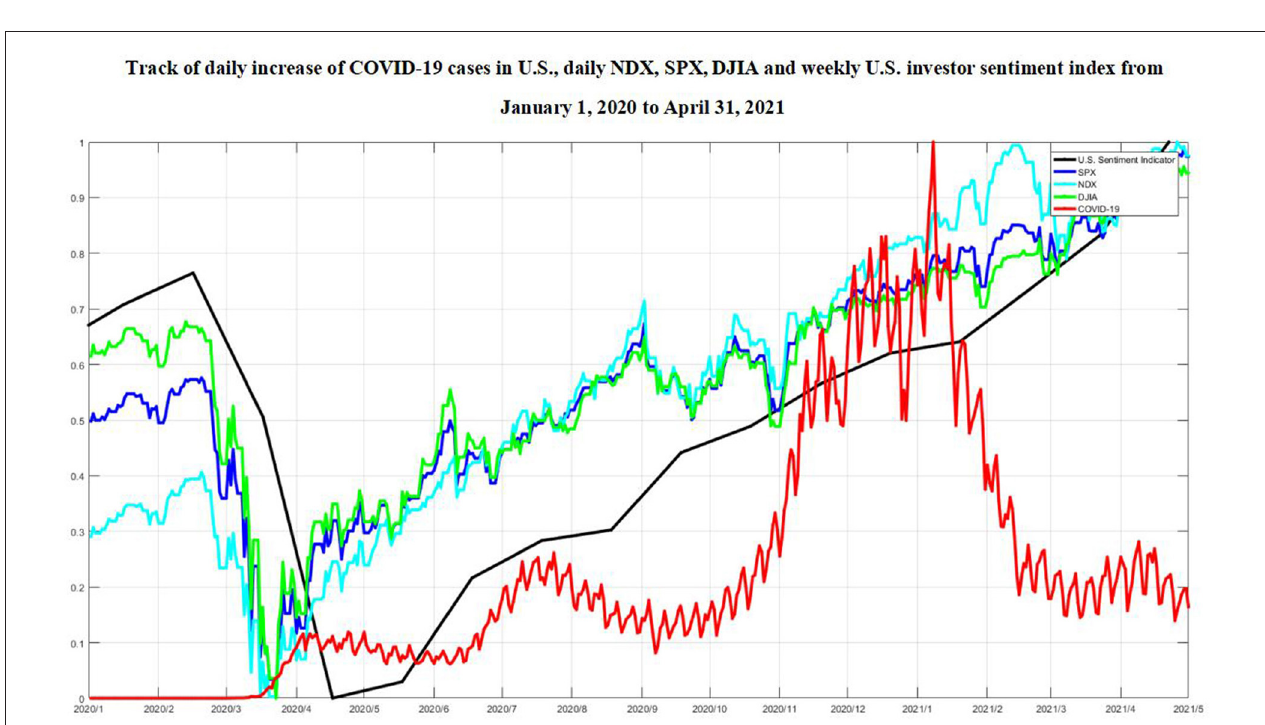
FIGURE 2 | Track of daily increase of COVID-19 cases in U.S., daily NDX, SPX, DJIA, and weekly normalized U.S. investor sentiment index from January 1, 2020 to April 31, 2021.